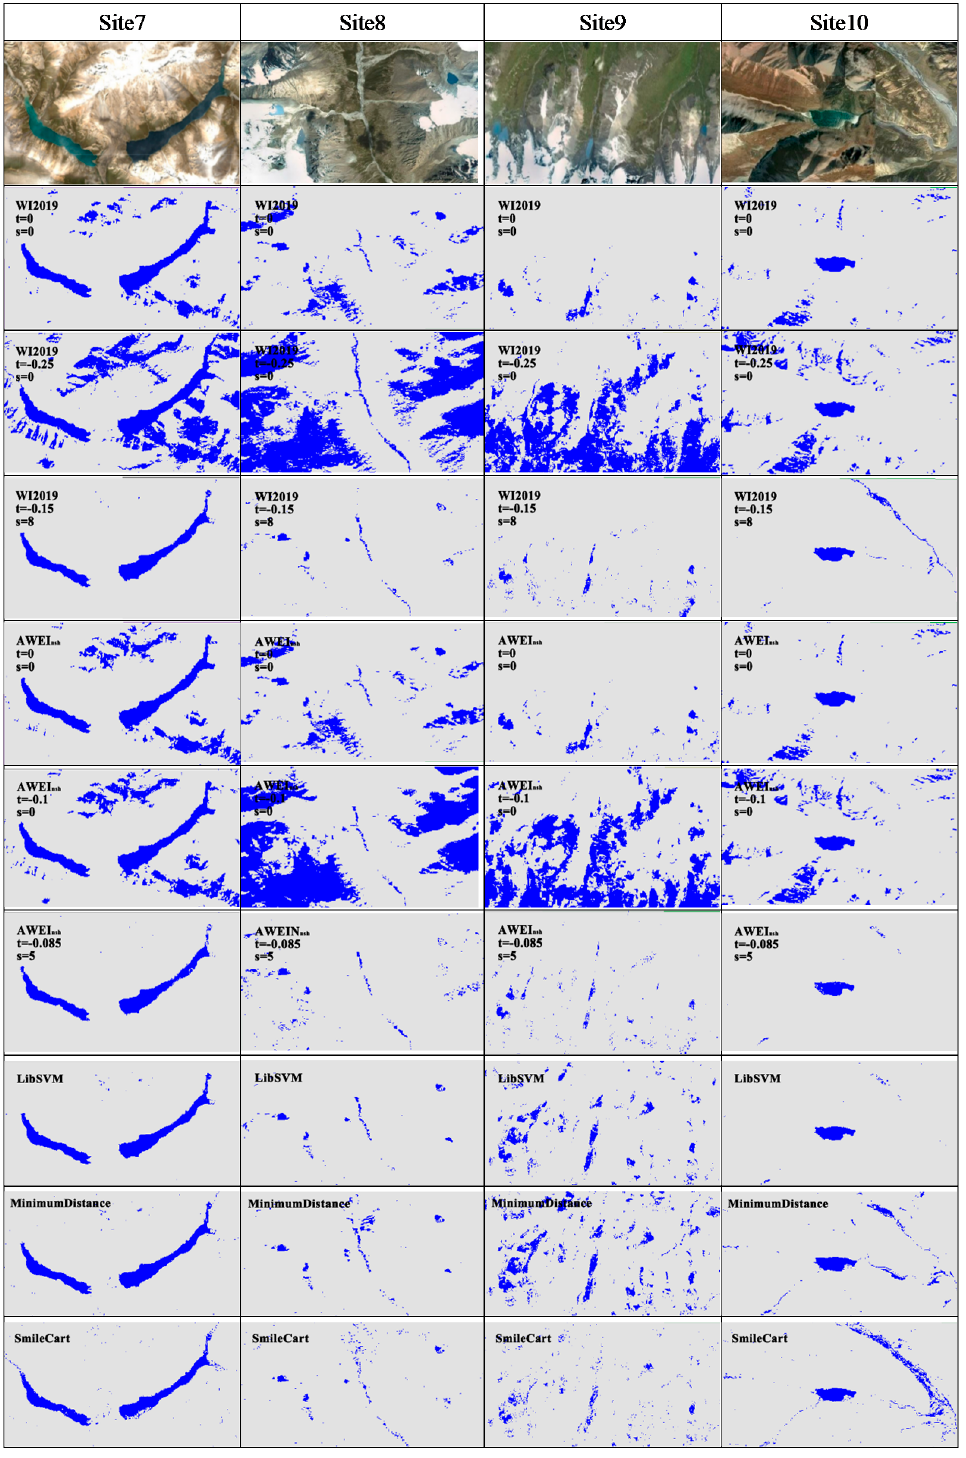
Figure 7. Comparison of extraction effects of different water extraction methods in more complex terrains.